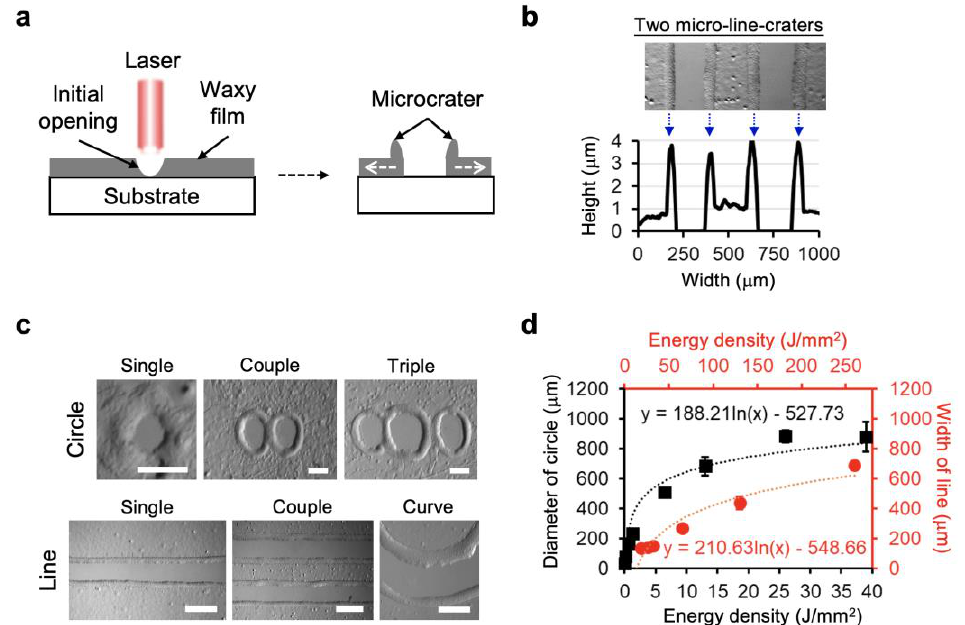
Figure 1. Laser direct writing on waxy films coated on glass slide substrates: ( a ) Illustration showing the waxy microcrater patterns carried by laser direct writing. ( b ) Surface profile of the two typical micro-line craters by laser writing on the waxy film-coated substrate. ( c ) Representative micrographs showing the capability of fabricating both circle and line patterns on the substrate by laser writing. Scale bars are 50 µm in top panel and 200 µm in bottom panel. ( d ) Relationship between the fabricated size of circle (black color) or line (red color) pattern and the energy density applied by the CO 2 laser. Data represent the mean ±SD, n = 3 for circle pattern and n = 4 for line pattern.